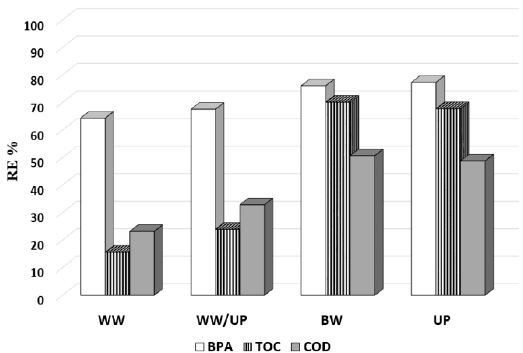
Figure 4. Removal efficiency, RE%, in various water matrices. Experimental conditions: fiber loading = 1 g; water volume = 50 mL; C 0 = 15 mg/L; pH = 5; contact time = 60 min. The errors in the calculated removal efficiency are 1% for BPA, 2% for TOC and 4% for COD.